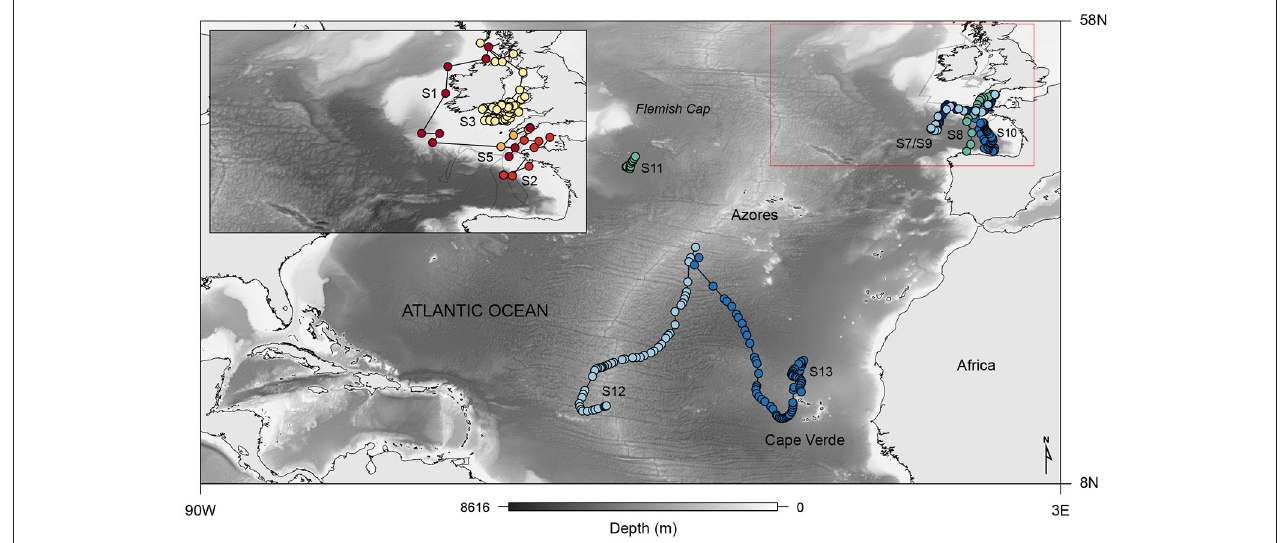
FIGURE 2 | Map showing the general movement patterns of four basking (S1, S2, S3, and S5; top-left inset) and seven blue (S7–S13) sharks tagged with PSAT tags from which archival data was retrieved, overlaid on bathymetry; red box outlines the eastern North Atlantic area, which is shown in detail in the upper left